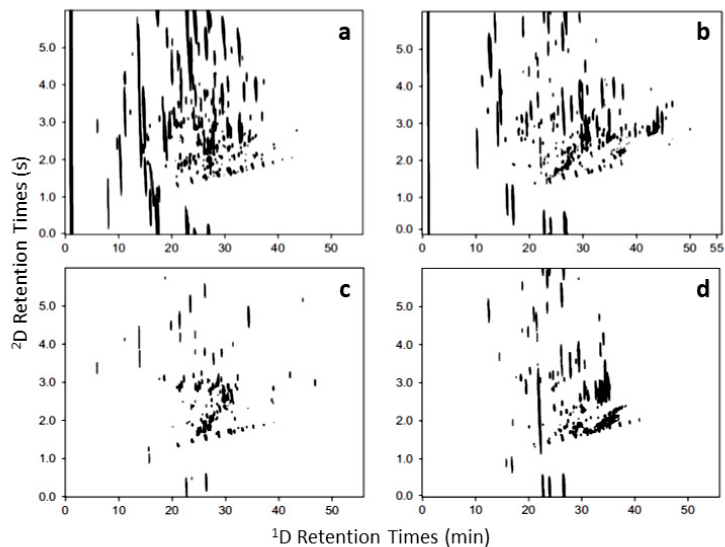
Figure 8. GC × GC-FID volatile profiles from the smoke of four different incense samples: ( a ) lotus-scented, ( b ) red Tibetan, ( c ) medicine herb and ( d ) brown (‘smokeless’). Source: adapted with permission from Tran and Marriott [123,124].